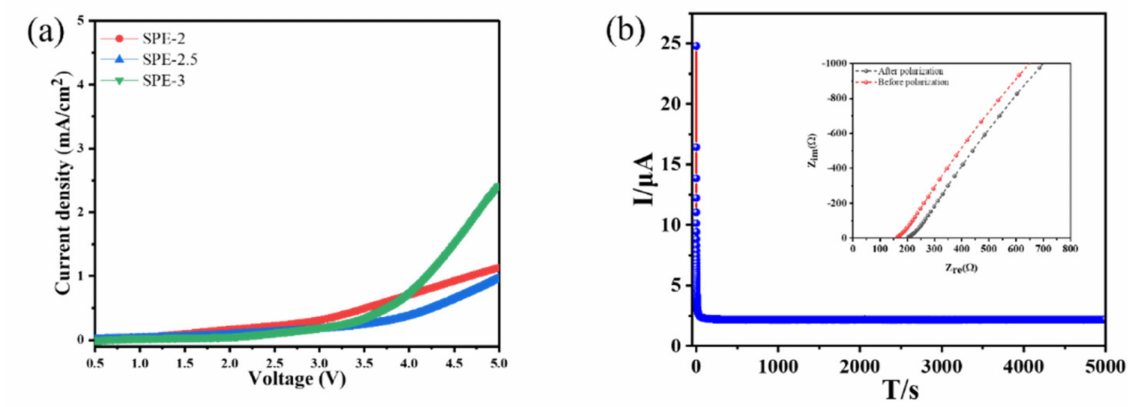
Figure 6. ( a ) Current density vs. voltage plot of SPE-2, SPE-2.5, and SPE-3. ( b ) Chronoamperometric polarization plot of the electrolyte-based symmetry Li/SPE-2.5/Li Swagelok cell at 10 mV for 5000 s (inset exhibits the Nyquist curves of the cell before and after